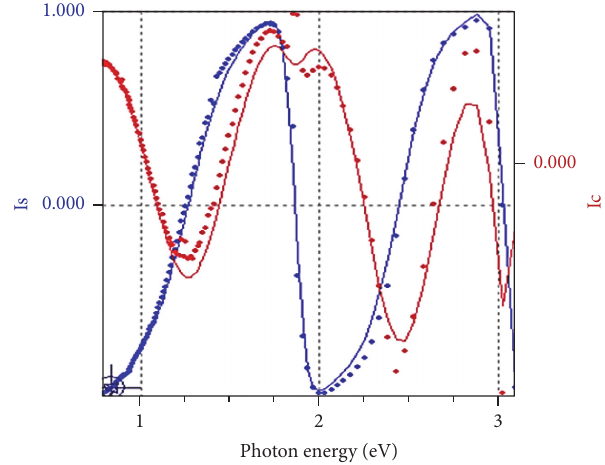
Figure 5: Spectroscopic ellipsometry data fitting procedure of TiO 2 NMO.